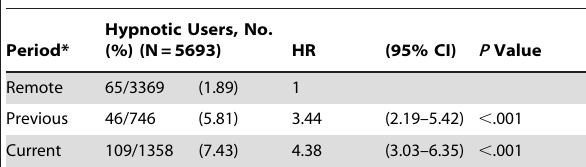
Table 5. Hazard ratios of dementia stratified by the period between the last hypnotic prescription and the dementia